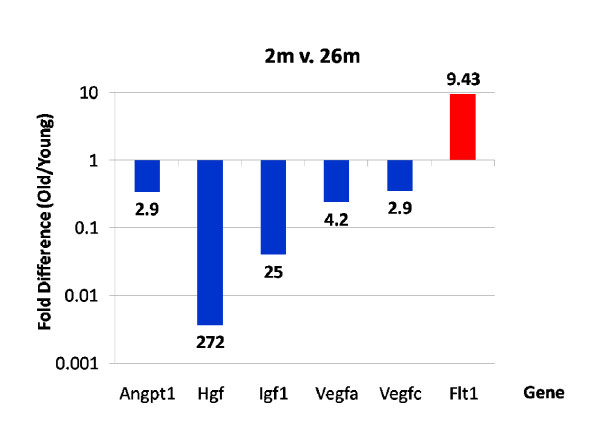
RT-PCR measurement of Growth factor transcripts.   RT-PCR was performed as described in Methods.  These analysis confirmed marked down regulation of the growth factor cytokine genes with age.  The largest changes were the HGF gene (>272-fold) and IGF-1 gene transcripts.